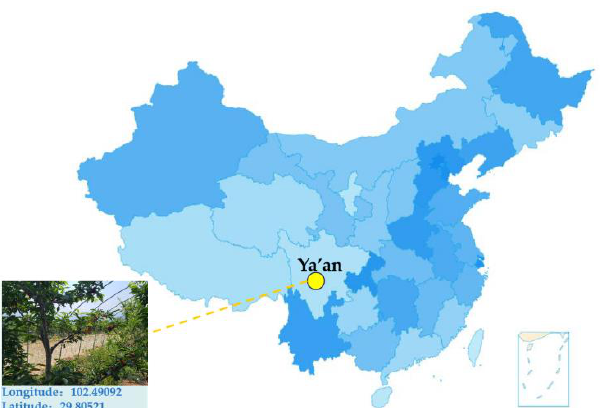
Figure 1. The location of sweet cherry orchard in Hanyuan County, Ya‘an, as marked on the map.